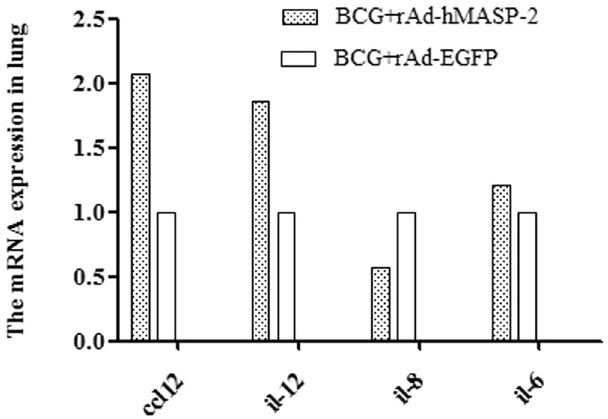
Figure 7. The mRNA expression for il-6, ccl12, il12 and il-8 in lung (n = 3 per group). Data represent mean values of conditions performed in